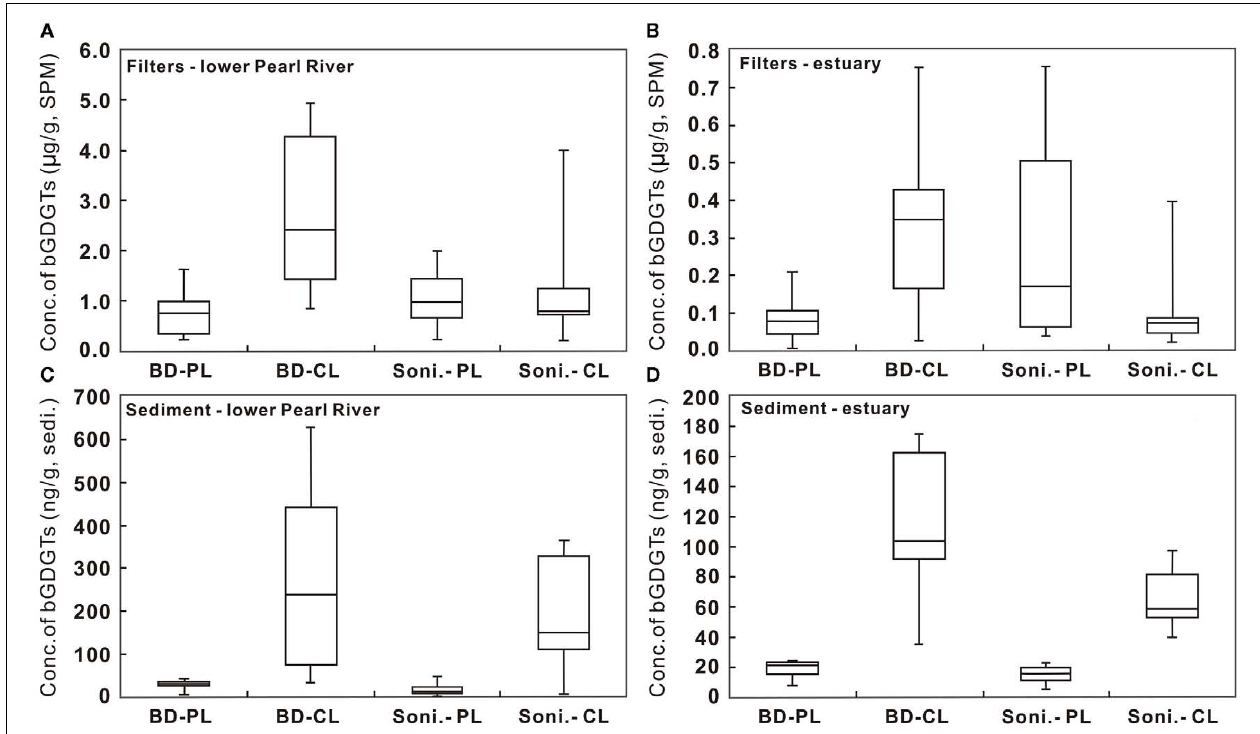
FIGURE 3 | Comparison of concentrations of C- and P-bGDGTs extracted using the sonication (Soni) and Bligh and Dyer (BD) methods for water column (A,B) and sediment (C,D) samples from the lower Pearl River and estuary. CL, core lipids; PL, polar lipids.